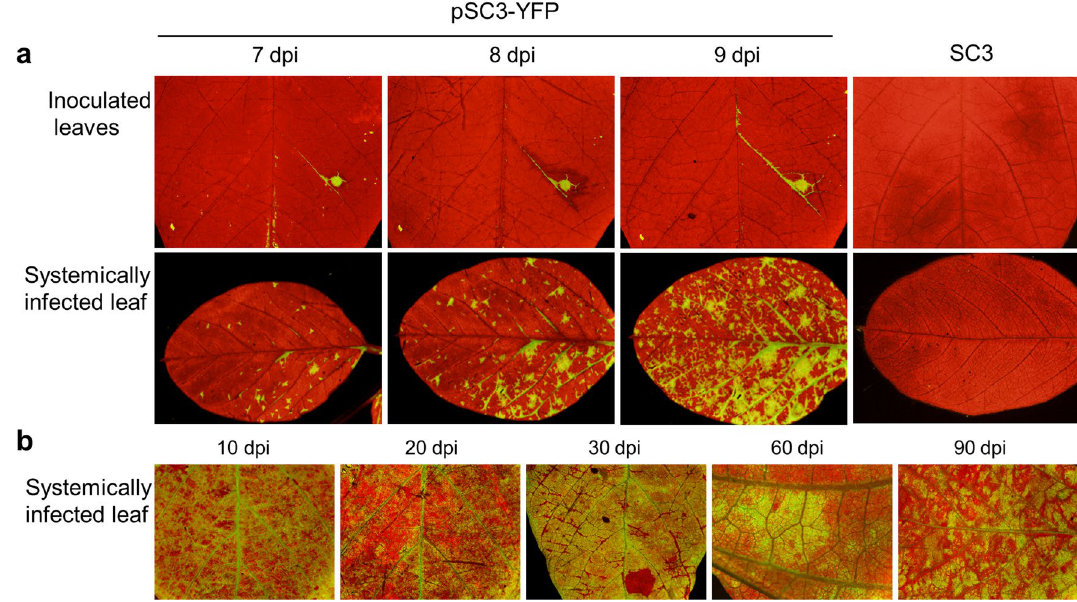
Fig. 3 Local and systemic infection of SMV-YFP in susceptible soybean cultivar NN1138-2. a At 7 days post-inoculation (dpi), upper leaves of inoculated soybean cultivar NN1138-2 start to accumulate SMV-YFP, while the veins of the inoculated leaves start to show signs of viral movement. At 8 or 9 dpi, the upper leaves accumulated more virus, while the inoculated leaf shows a clear path of viral movement through the vein that near the inoculation site. The same leaves were continuously imaged at 7, 8, and 9 dpi. The wild type SC3 strains were inoculated as control. b Extended observation of SMV-YFP infected upper leaves at 10, 20, 30, 60, and 90 dpi under a stereoscopic fluorescence